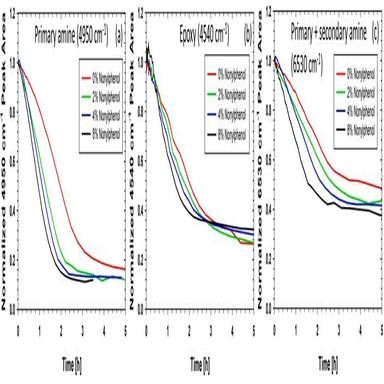
Time evolution of the primary amine (a), epoxy (b) and primary + secondary amine (c) peak areas during cure of Epon 828 and MXD with varying amounts of nonylphenol. Data obtained using a benchtop near-IR spectrometer (Bruker Equinox 55) at 25 ◦C.